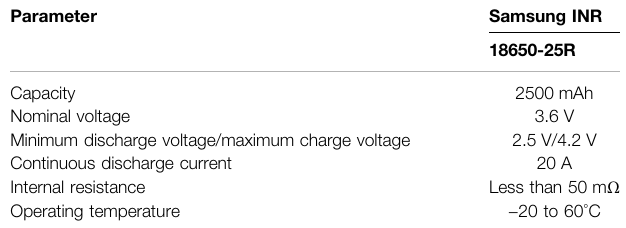
TABLE 2 | Basic electrical characteristics of the INR18650-25R.